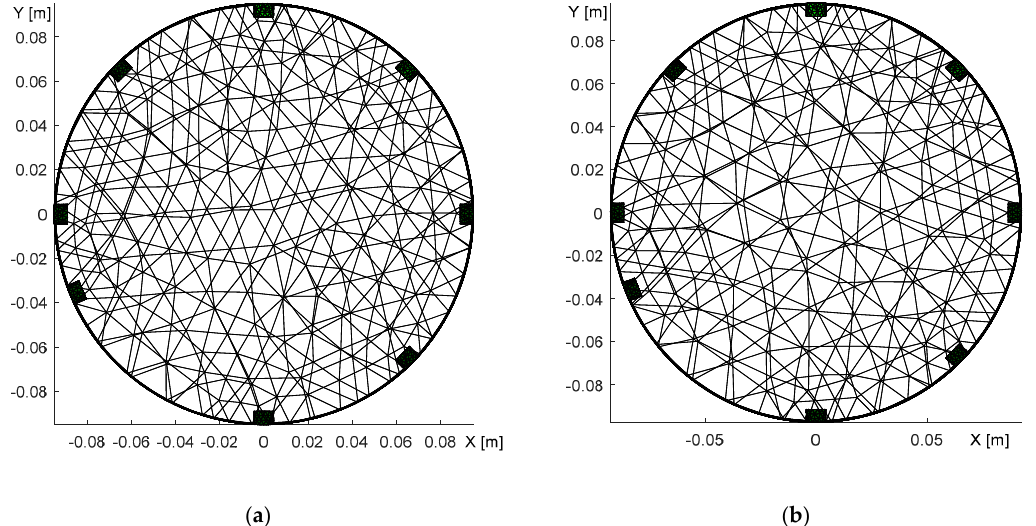
Figure 13. A top view of the optimized model, with the electrode shift obtained through adjacent driving: ( a ) the circular domain; ( b ) the elliptic domain.